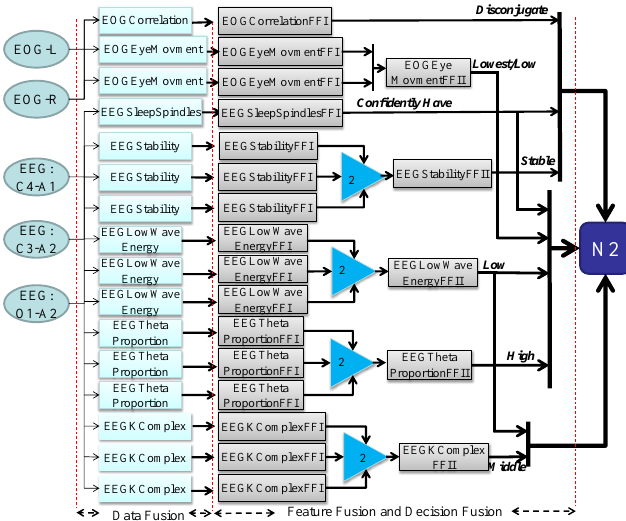
Figure 3. Classification of stage N2